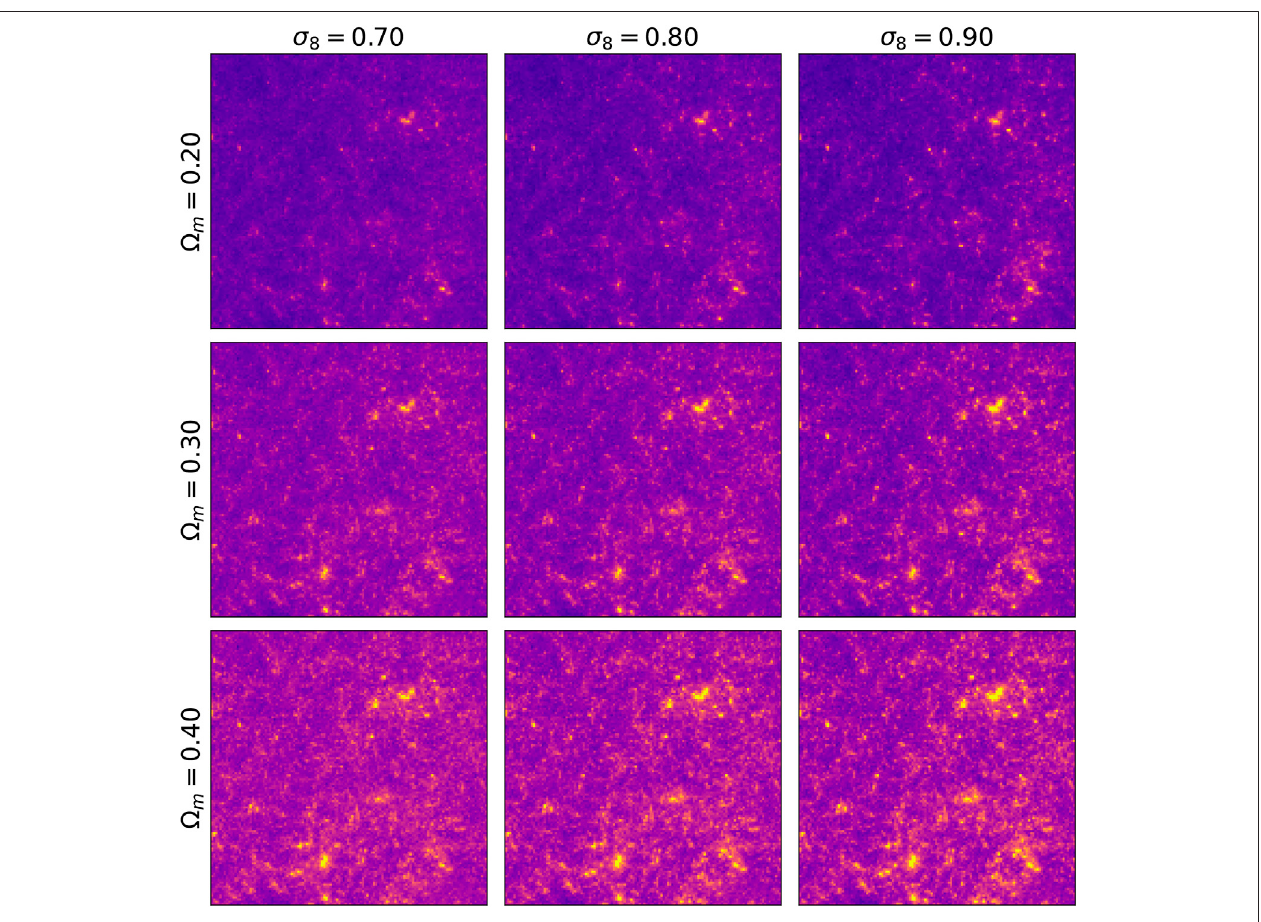
top left: signi fi cance of the difference s SSIM in Multi-Scale Structural Similarity Index ( Eq. 4 ), top center: Fréchet distance using a CNN regressor ( Eq. 5 ). Note that for a Gaussian distribution, a difference of FID 1 / 2 (cid:2) 1 corresponds to either a 1 σ shift in the mean or 1 σ difference in standard deviation, top right: normalized Wasserstein-1 distance of the pixel value distribution. For a Gaussian distribution, a 1 σ change in the mean corresponds to W 1 (cid:2) 1, and an increase in standard deviation of × 2 to W 1 ≈ 0 . 8, bottom left: average fractional differences in the power , spectrum f C ℓ , bottom center: fractional differences in the power bispectrum f B ℓ bottom left: fractional difference in the Frobenious norm of the correlation matrices f R ( Eq. 3 ).